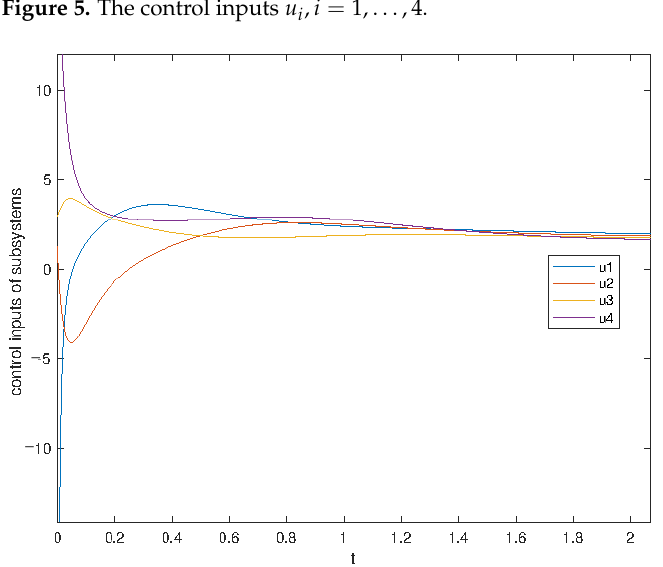
Figure 6. The control inputs u i , i = 1, . . . ,4 when t between 0 and 2